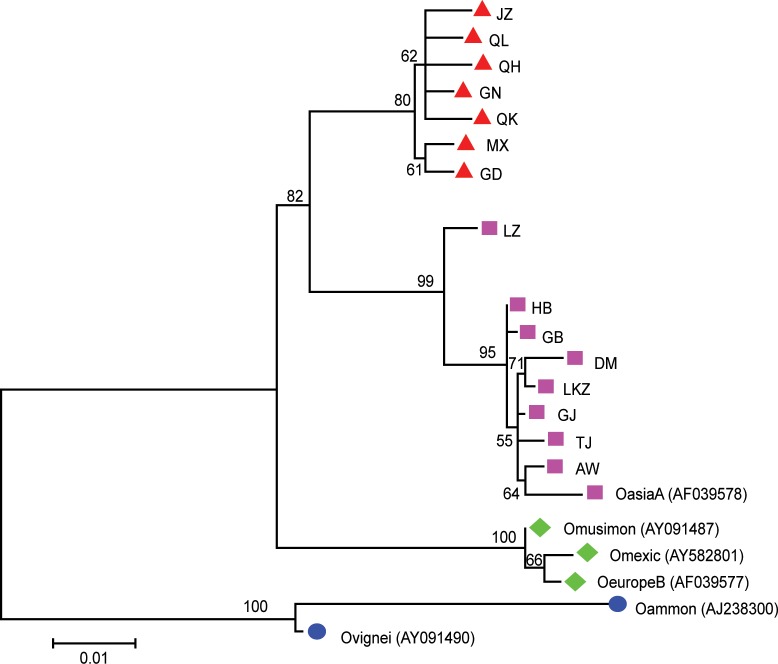
A Neighbor-joining Phylogenetic Tree of the 21 Populations based on 642 Sequences of mtDNA D-loop.The distances were computed using the Maximum Composite Likelihood method and are in the units of the number of base substitutions per site.